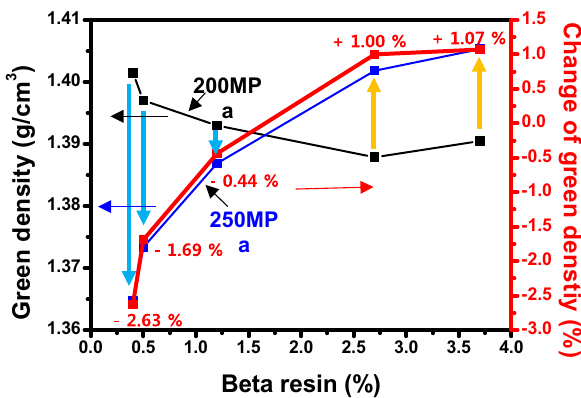
Figure 5. Changes in green density depending on the β-resin content.